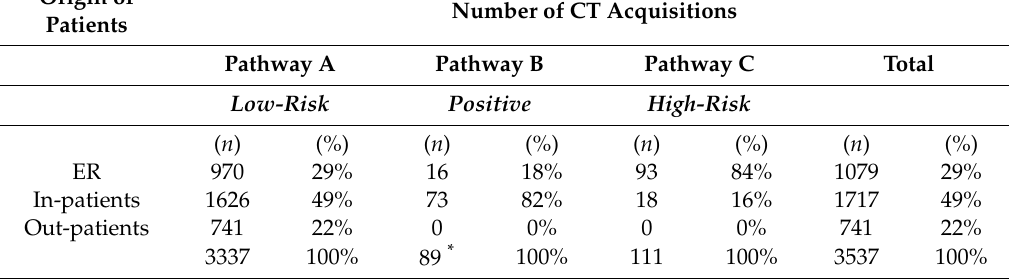
Table 2. Number of computed tomography examinations performed in our tertiary center from the 21st of February to the 12th of April 2020 for Pathways A, B, and C (low-risk, COVID-19 patients, and high-risk patients) subdivided according to the origin and the risk of infection.